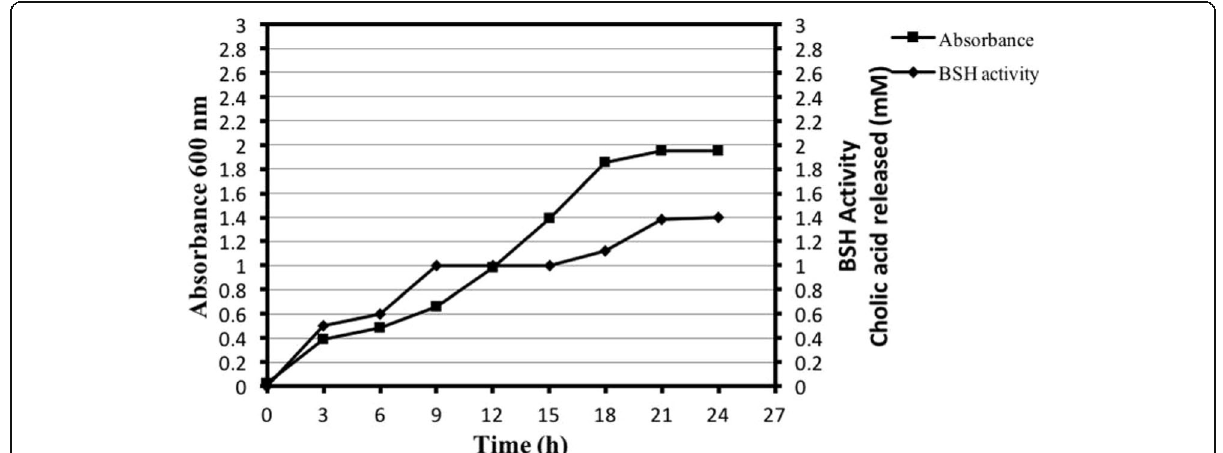
Fig. 4 Growth profiles and BSH activity patterns for Lactococcus lactic subsp. lactis